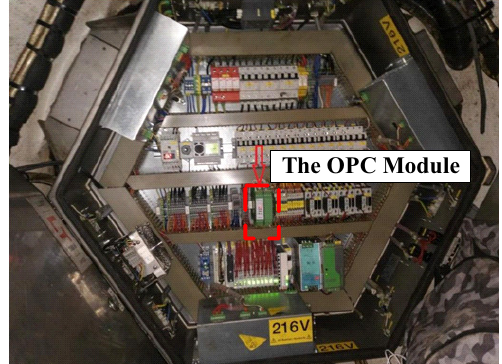
Figure 12. Installation diagram of sensors and mechanical devices. ( a ) is the lateral view, ( b ) is the front view, and ( c ) is a perspective drawing.